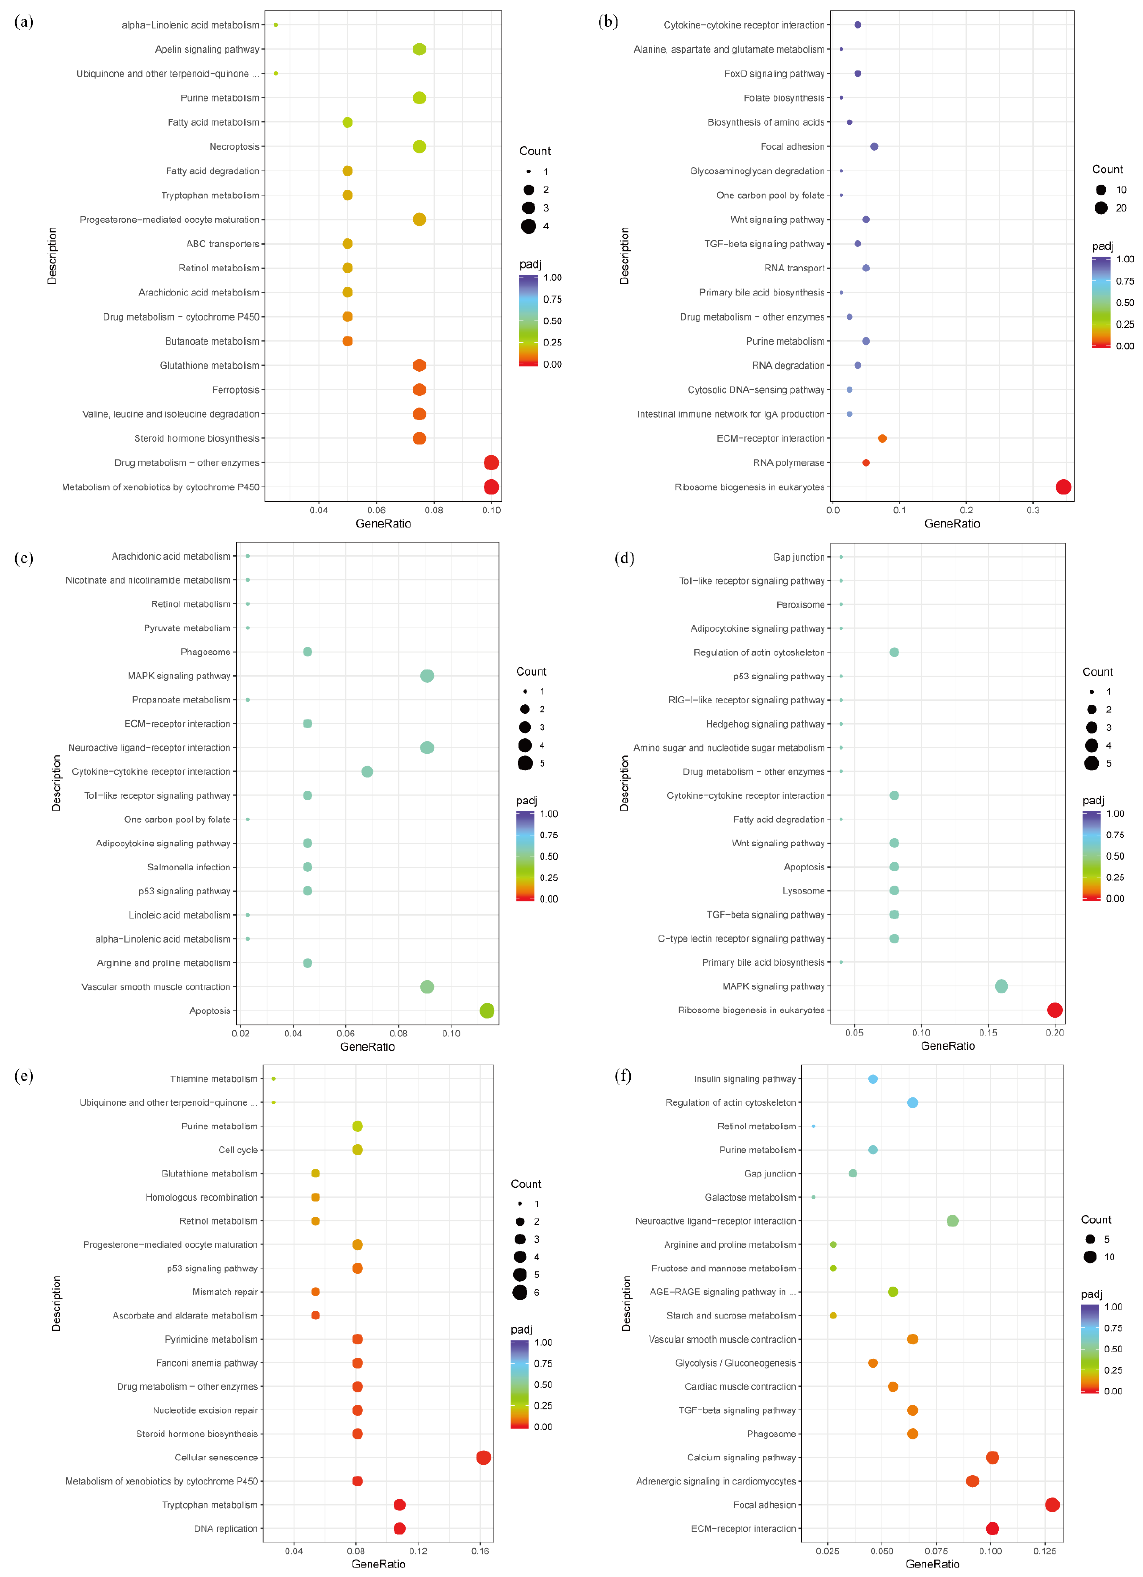
Figure 6. KEGG analysis of DEGs in different salinity comparison groups. ( a ) Smsh vs. Smsc dot plot of up-regulated DEGs; ( b ) Smsh vs. Smsc dot plot of down-regulated DEGs; ( c ) Smsh vs. Smsl dot plot of up-regulated DEGs; ( d ) Smsh vs. Smsl dot plot of down-regulated DEGs; ( e ) Smsl vs. Smsc dot plot of up-regulated DEGs; and ( f ) Smsl vs. Smsc dot plot of down-regulated DEGs.